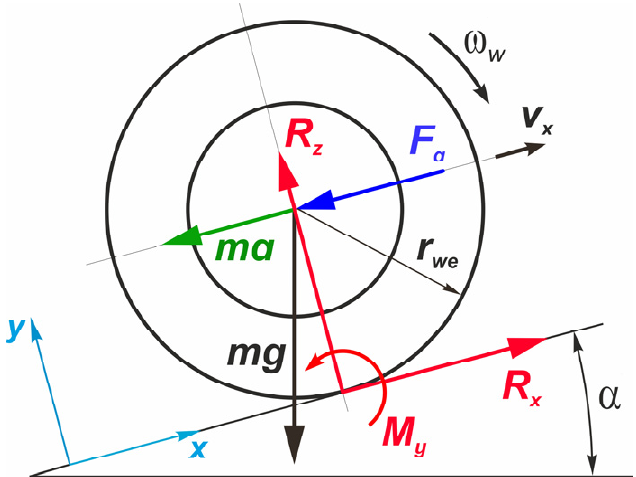
Figure 5. Scheme of forces acting on a conditional vehicle.